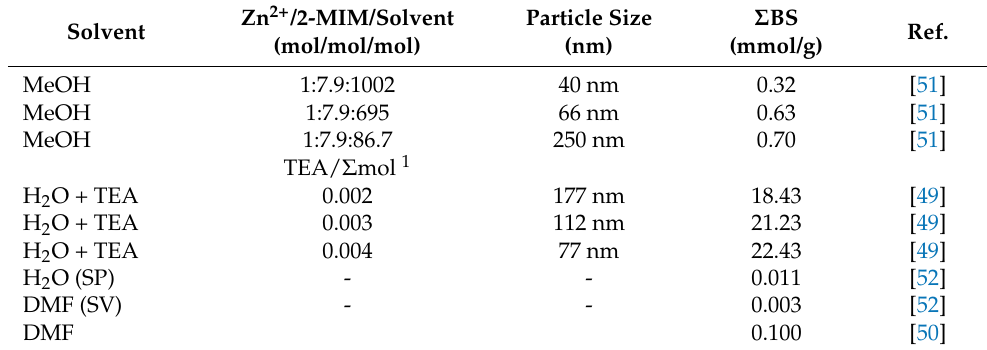
Table 6. The number of the basic sites in ZIF-8 according to CO 2 -TPD analysis.